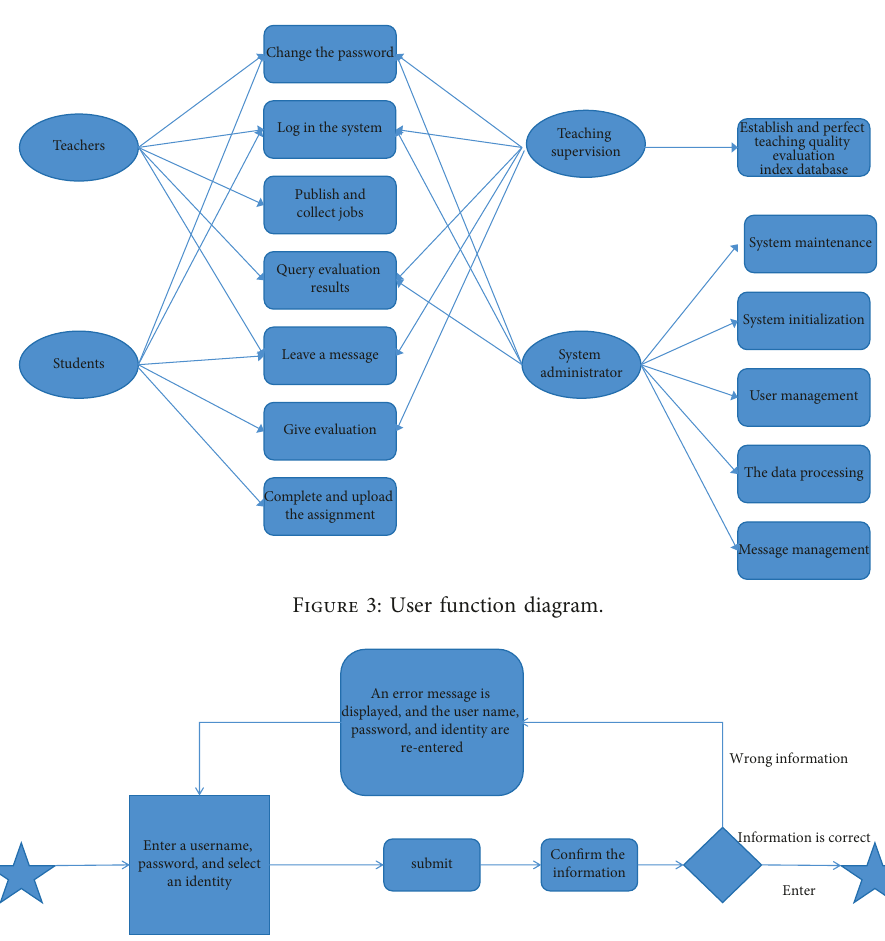
Figure 2: Model of teaching quality evaluation system.